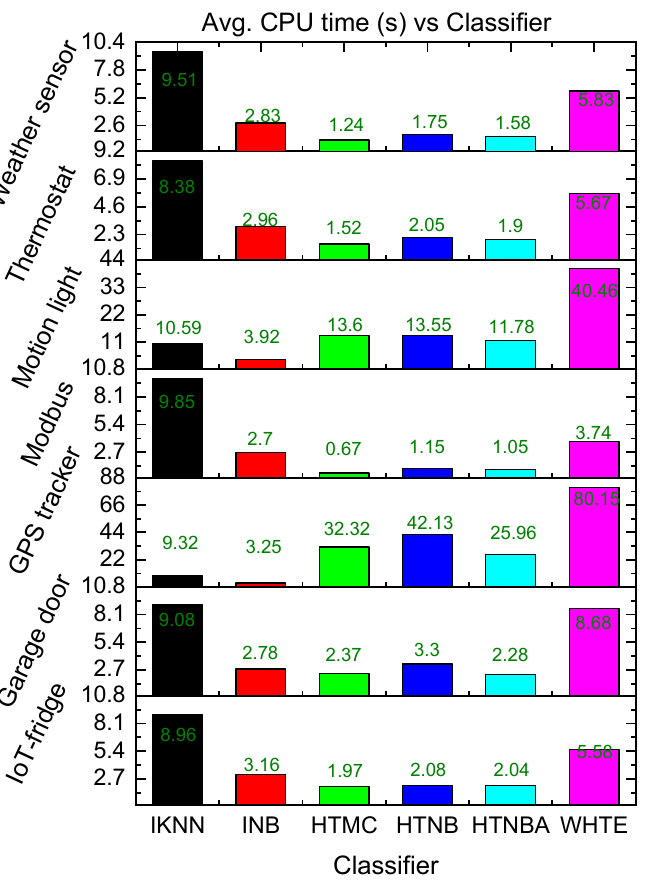
Figure 8. The comparison of the proposed classifiers in terms of average CPU time among all the datasets.